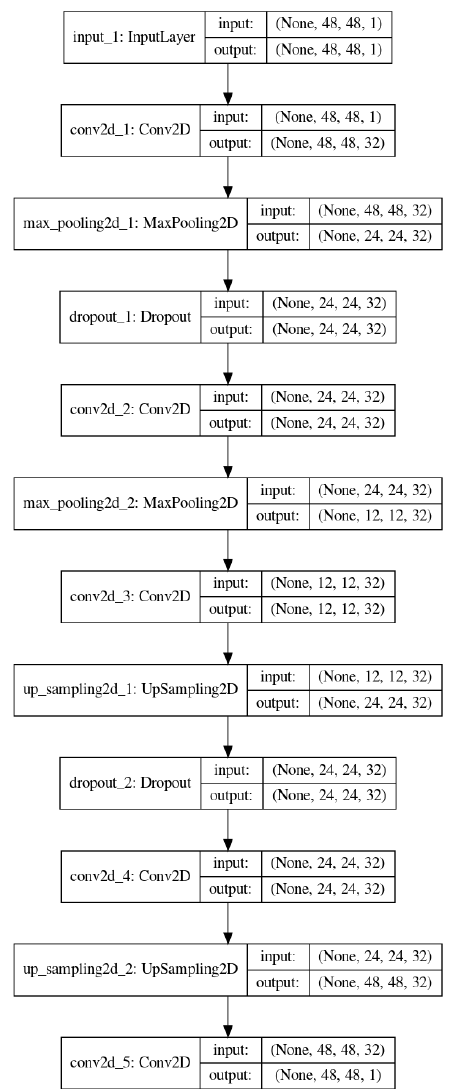
Figure 1. Basic architecture AutoEncoder